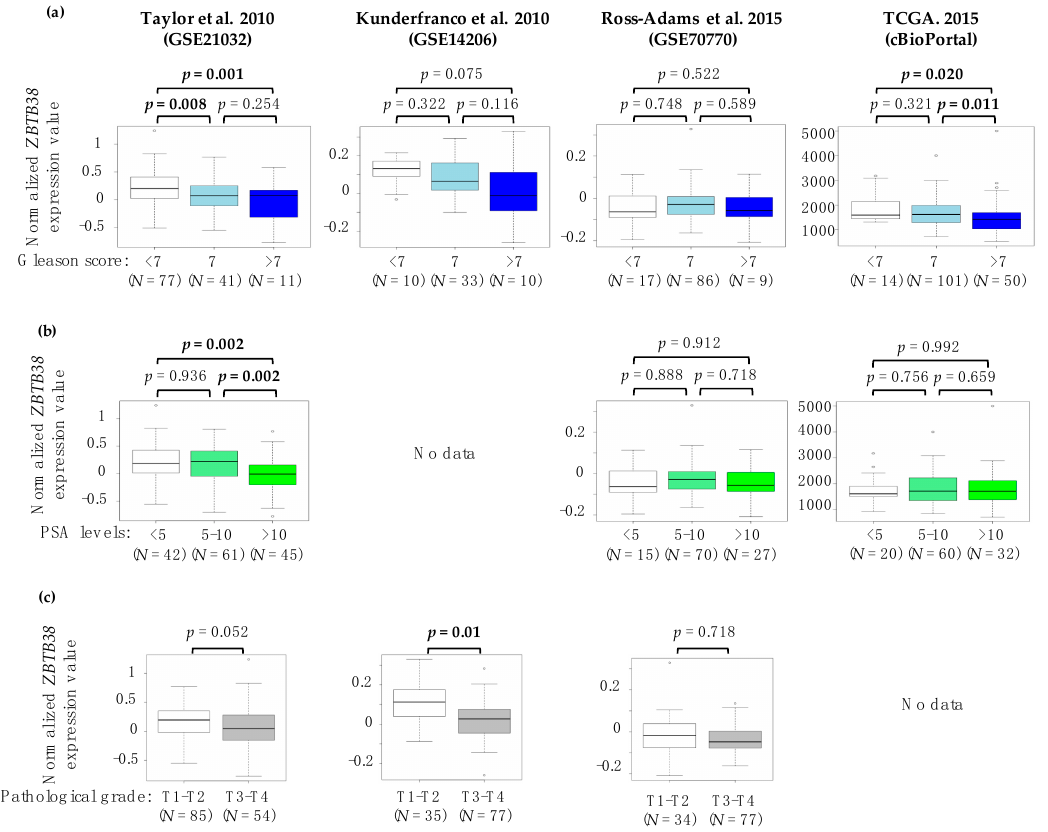
Figure 2. Low expression of ZBTB38 mRNA is correlated with advanced stage prostate cancer. Correlation between ZBTB38 mRNA expression and Gleason score ( a ), PSA levels at diagnosis ( b ) and pathological grade ( c ) in prostate cancer. N : number of patients per class. Significant p -value ( p < 0.05) are highlighted in bold.